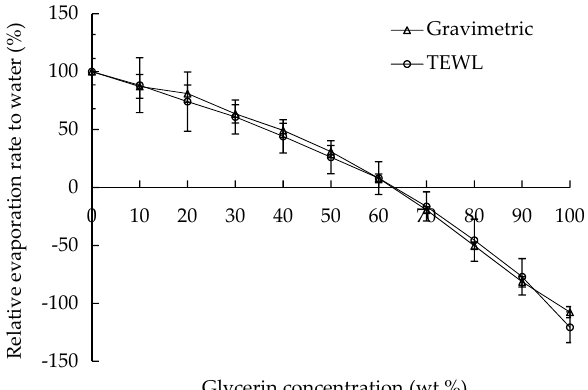
Figure 4. RERWs of glycerin solutions of various concentrations measured by using gravimetric and TEWL analyses.